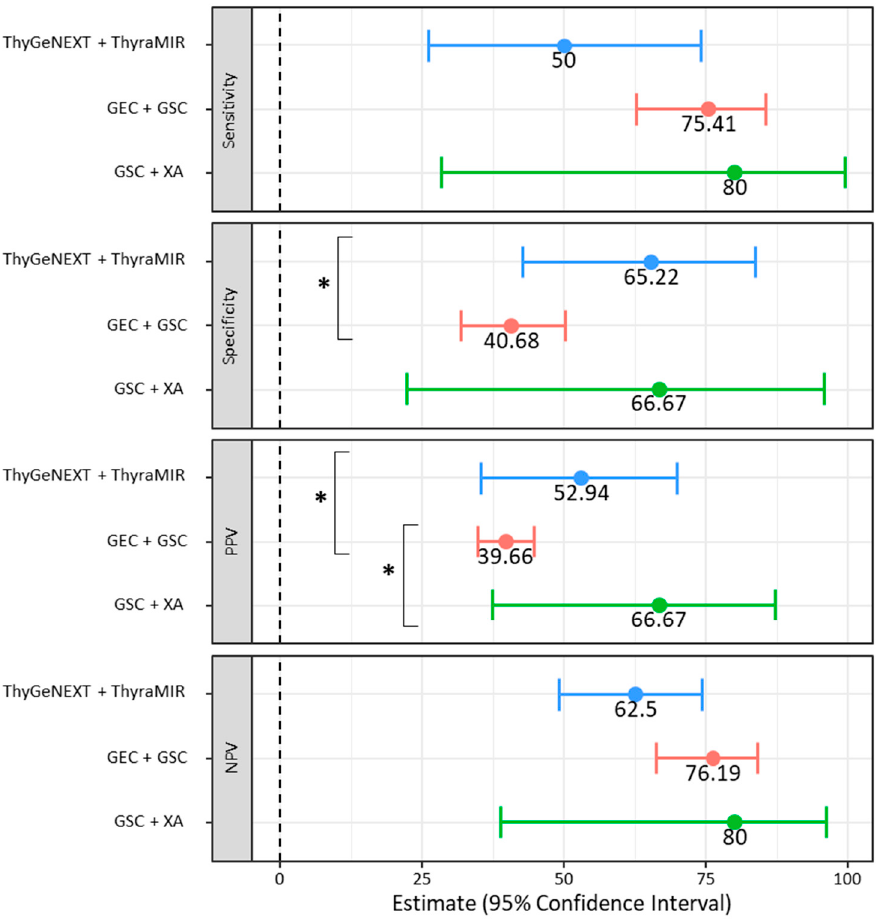
Figure 4. The sensitivity, specificity, positive predictive value, and negative predictive value with available surgical pathology in nodules undergoing the ThyGeNEXT + ThyraMIR, GEC + GSC, and GSC + XA molecular testing. PPV: positive predictive value; NPV: negative predictive value. * indicates p < 0.05.